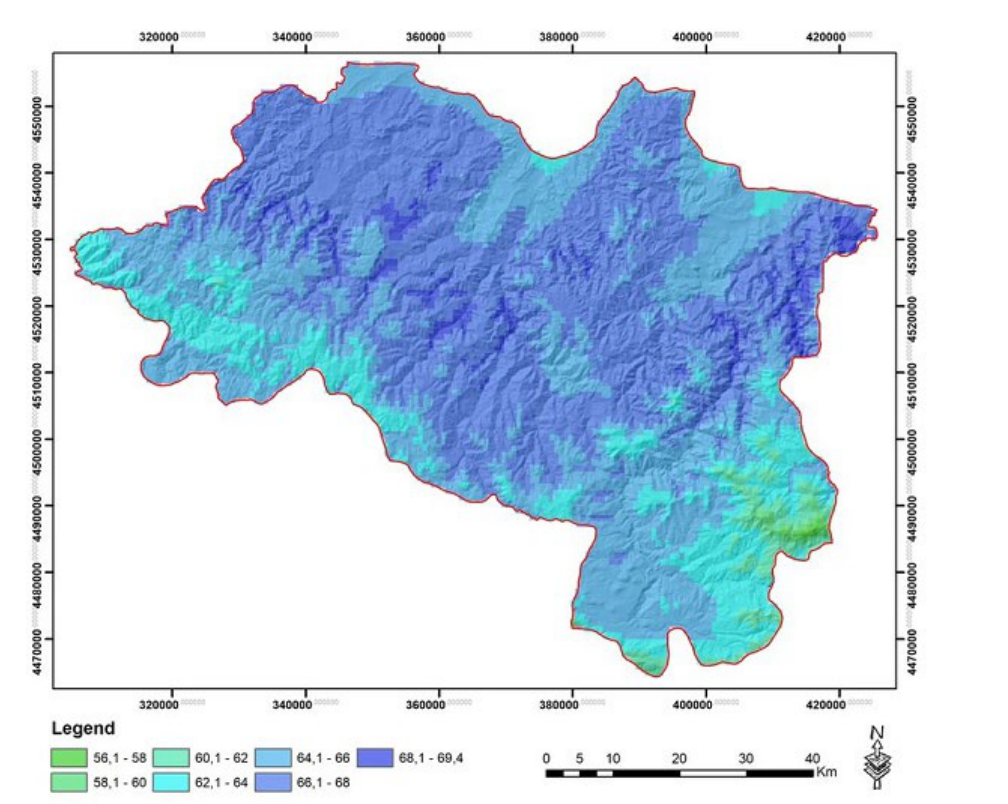
Figure 2 Percentage of Humidity in Ordu Province in Summer (Alrabiti